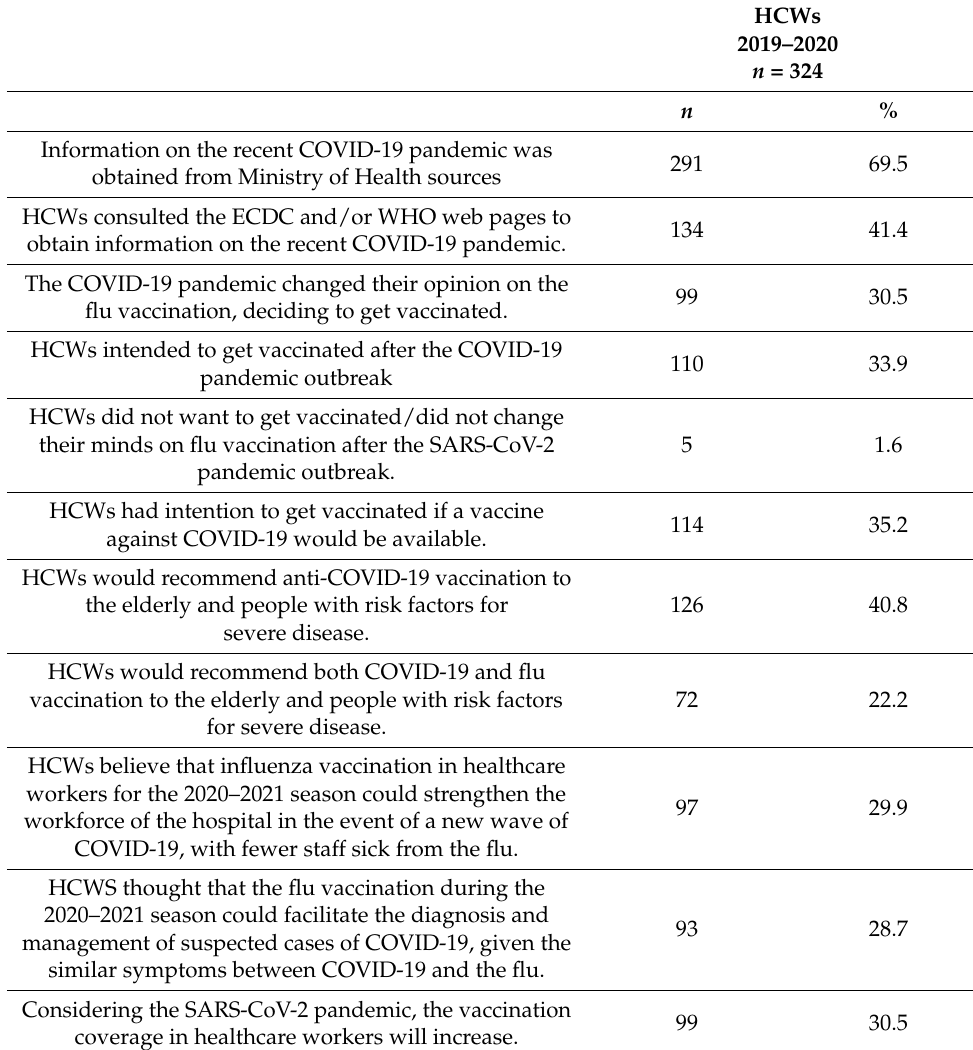
Table 3. Influence of COVID-19 pandemic on HCW opinions on vaccination in 2019–2020 flu